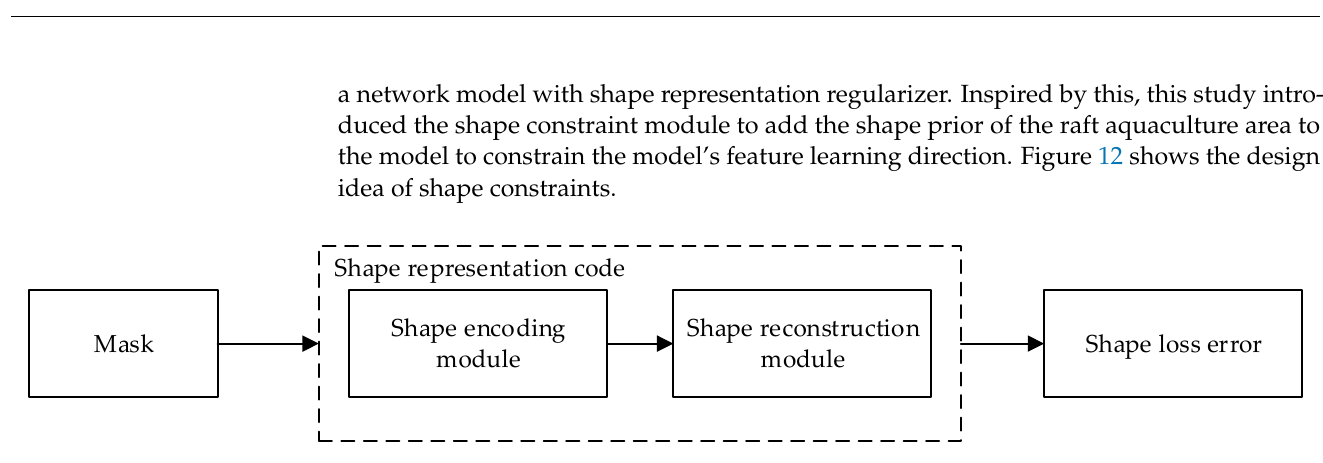
Figure 11. Schematic diagram of the attention module used in this study.